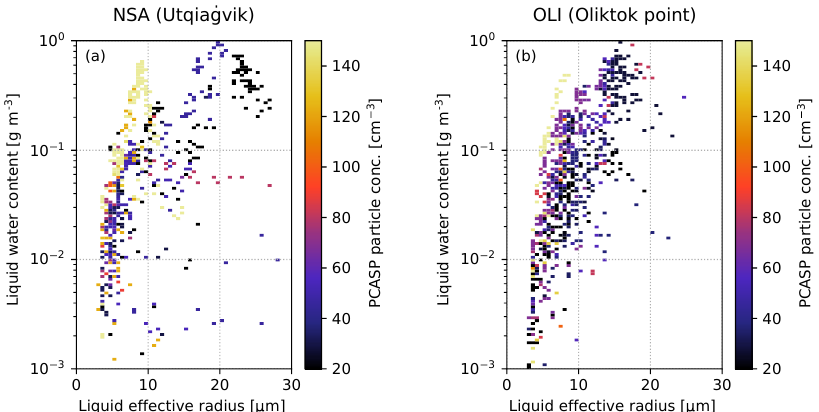
Figure 11. As Fig. 8, but with absolute values for PCASP particle concentration.